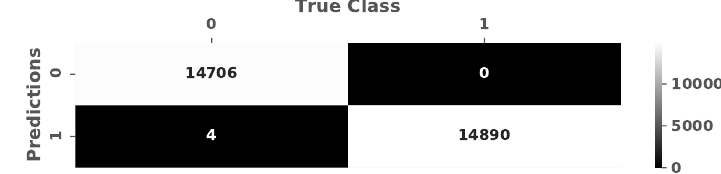
Figure 8. The confusion matrix of the test